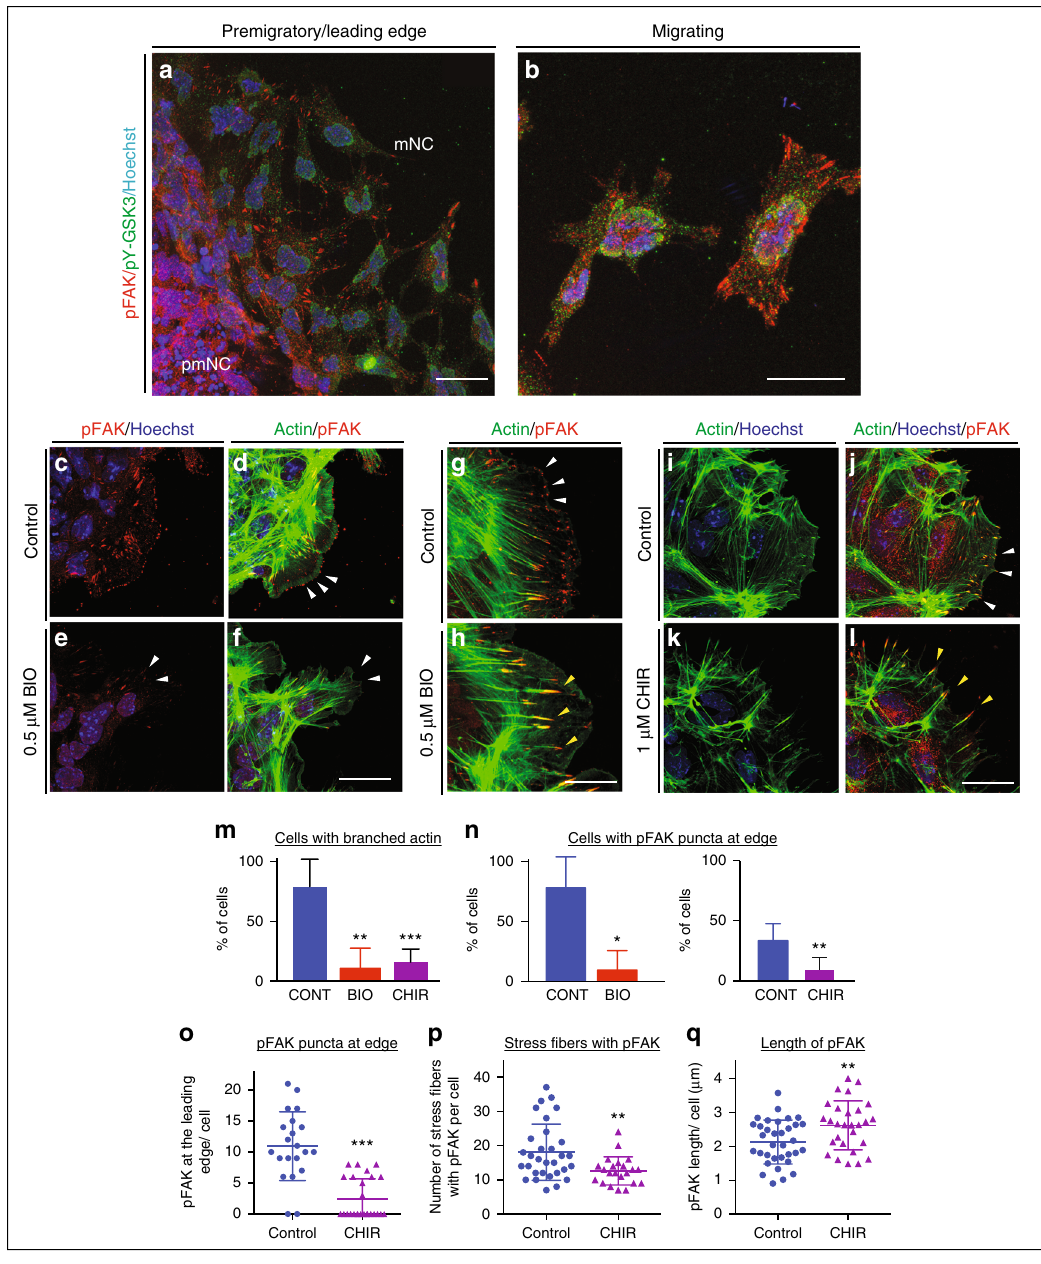
Fig. 4 GSK3 allows FAK localization to establish lamellipodial protrusions at the leading edge in migrating neural crest cells. a , b Immuno fl uorescence for pFAK-Y397 (pFAK, red) and pY-GSK3 (green). a In control explants, pFAK is found at the leading edge of the delaminating cells and in migrating cells. b In migratory neural crest cells, pYGSK3 and pFAK are mutually exclusive. c , d pFAK is found in puncta at the leading edge of the cell co-localizing with lamellipodia. e , f Upon GSK3 inhibition, the cells lose pFAK at the leading edge. g , h pFAK accumulates at the tips of actin-rich fi bres. Note the increase in length of pFAK associated with actin upon treatment with BIO ( h ). i , j Similarly, treatment with 1 µ M CHIR elicits the same response (white and yellow arrowheads). a – l Scale bar = 25 µ M. m , n Percentage bar charts representing a signi fi cant decrease in cells with branched actin ( m ) or showing pFAK puncta at the leading edge ( n ) when GSK3 is inhibited with either BIO or CHIR; ** p ≤ 0.001 and *** p ≤ 0.0001, two-tailed unpaired t -test. o – q Dot plots representing the number of pFAK puncta at the edge ( o ), the number of stress fi bres containing pFAK ( p ) and the length of of pFAK ( q ) in control and CHIR-treated cells; each dot represents one cell. ** p ≤ 0.001 and *** p ≤ 0.0001, two-tailed unpaired t